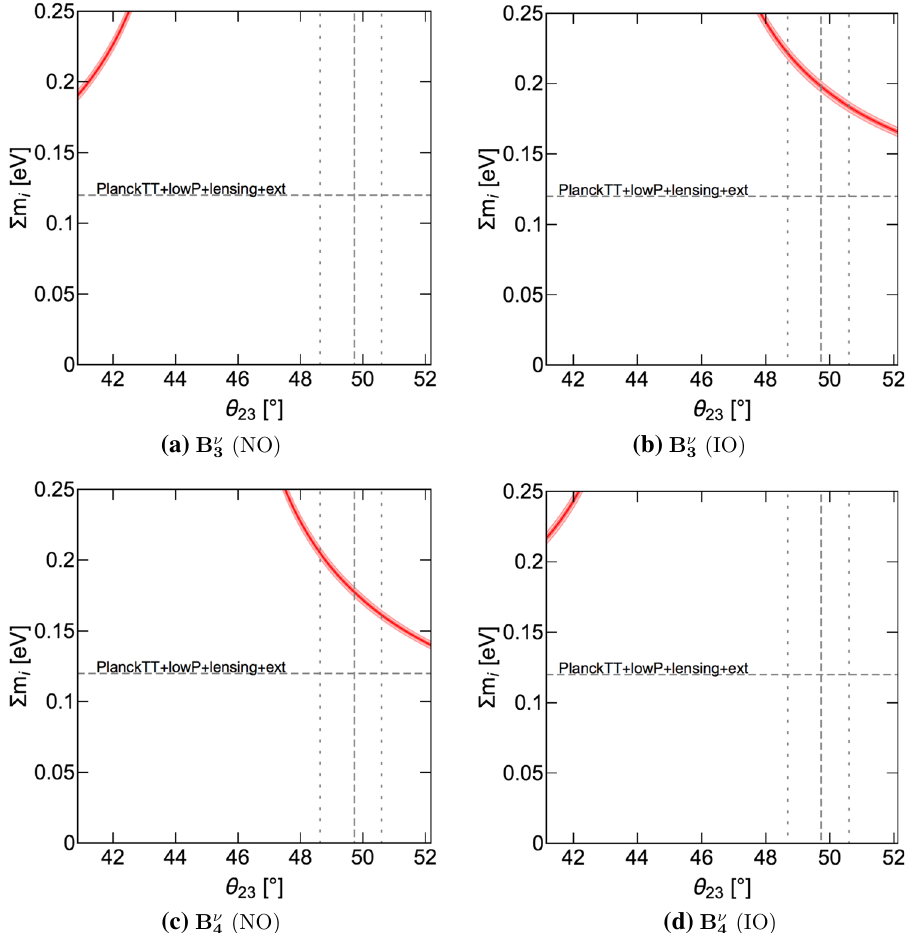
Fig. 3 The predictions for the sum of the neutrino masses in the doublet models. The red line shows the prediction as functions of θ 23 and the dark (light) red bands show the uncertainty coming from the 1 σ (3 σ ) errors of (cid:6) m 2 . The 3 (cid:12) vertical and horizontal lines are the same as Fig.